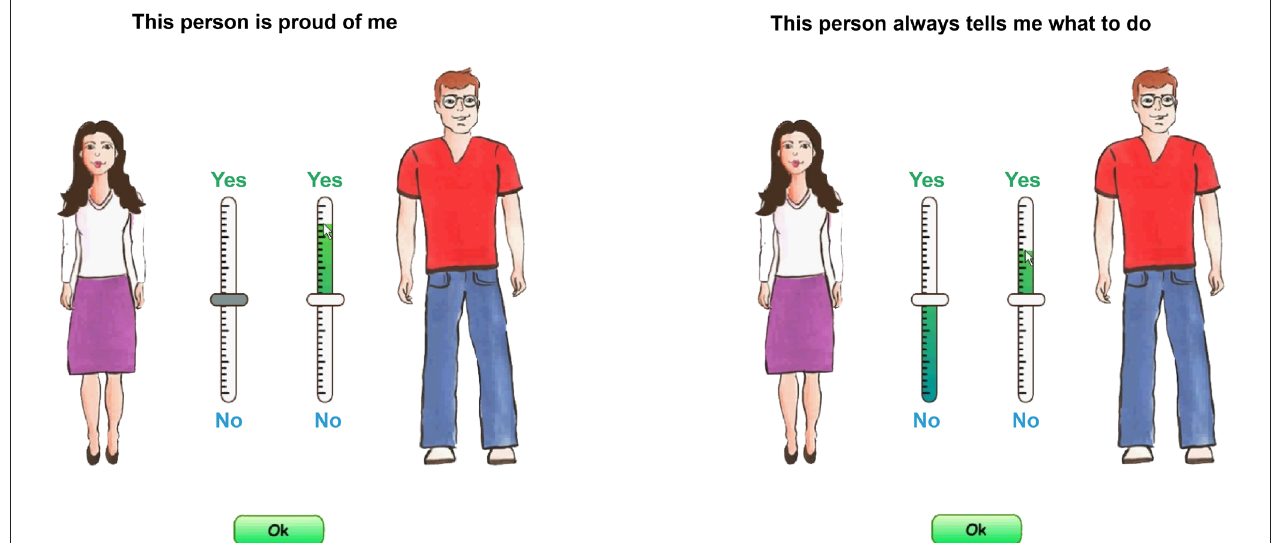
FIGURE 1 | Screen prints of the